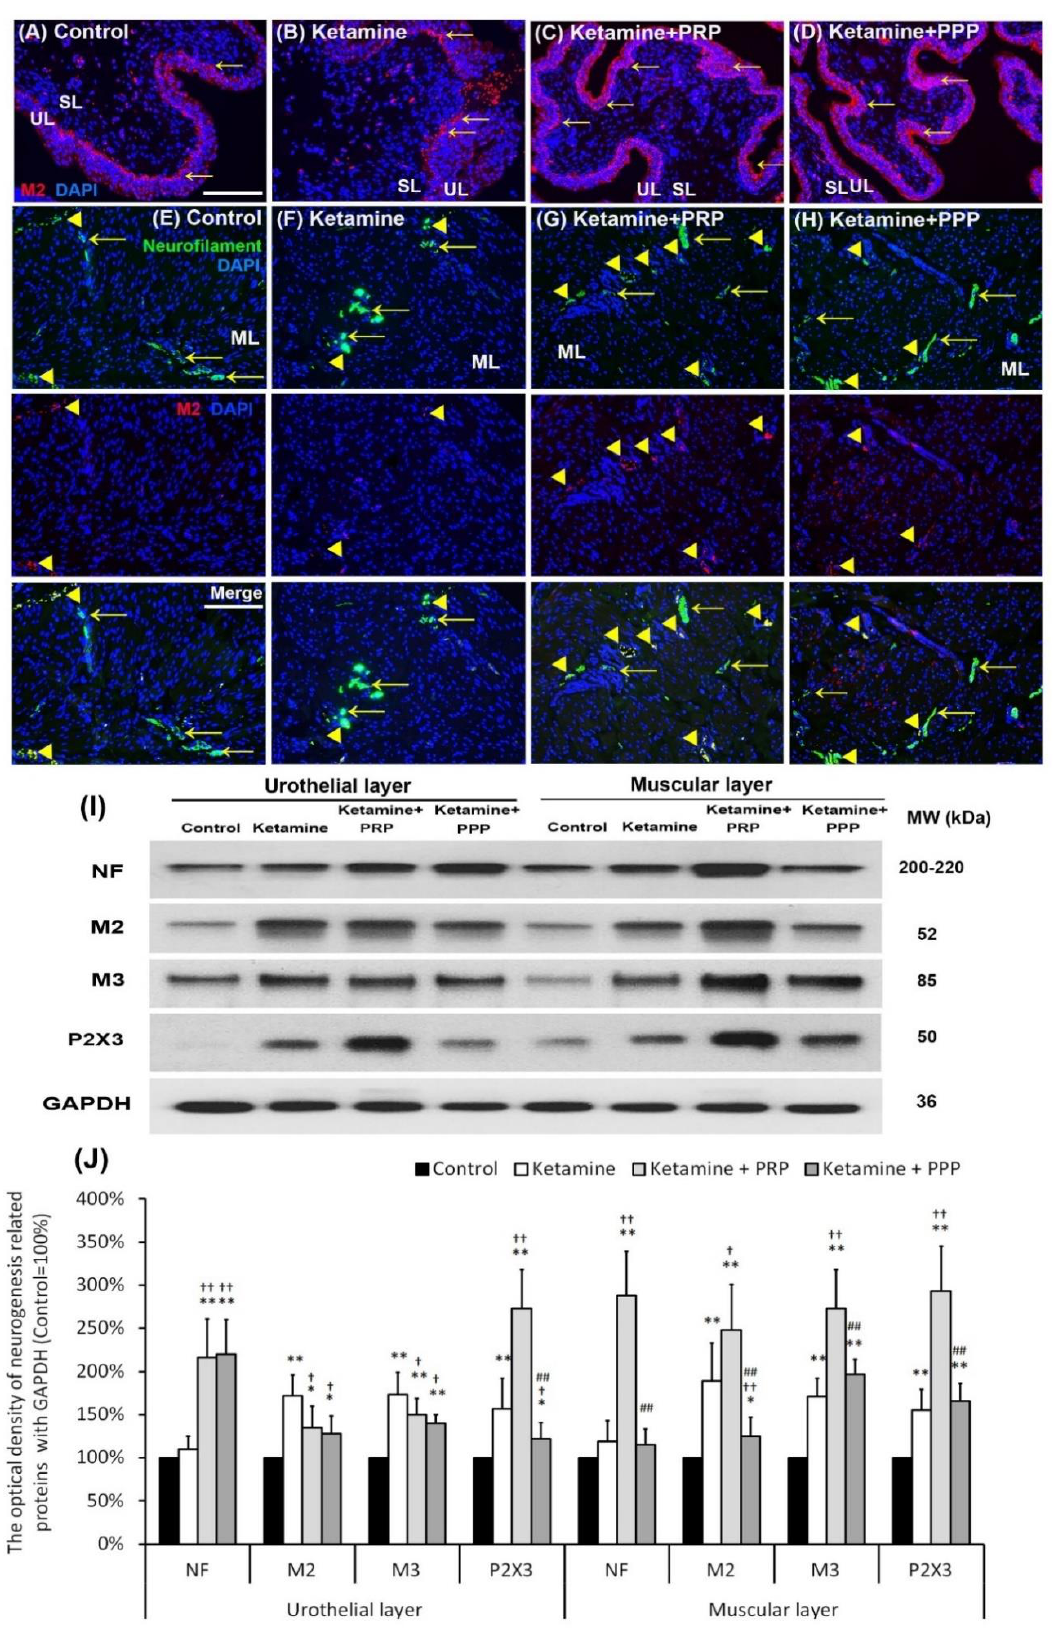
Figure 5. PRP treatment increased bladder nerve regeneration. The neurogenesis markers were analyzed by immunostaining ( A – H ) and western blotting analysis ( I , J ). ( A – D ): The M2